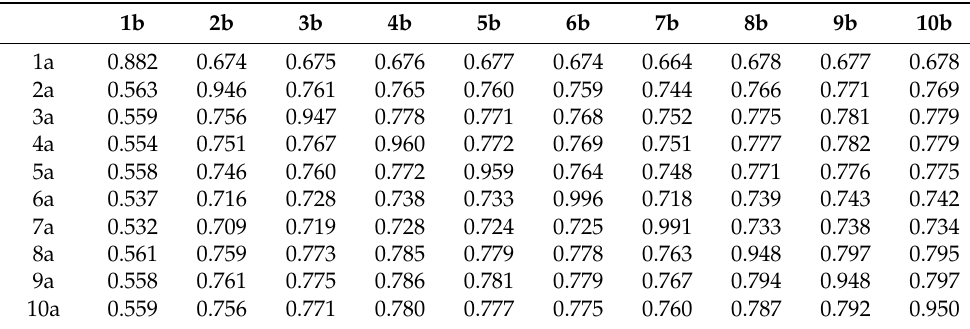
Table 5. The correlation values of the comparison of videos of different lengths (1a to 10a) with videos of 10 s (1b to